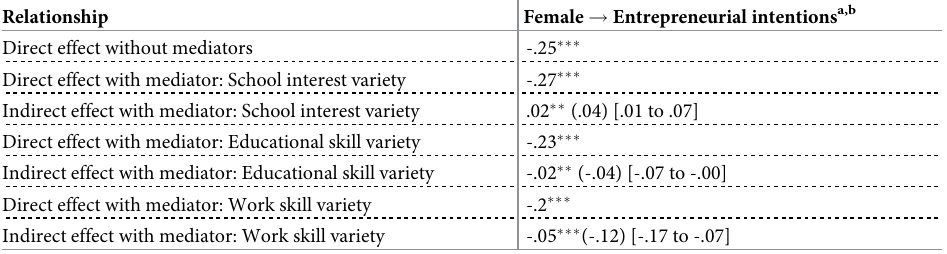
Table 3. Mediation